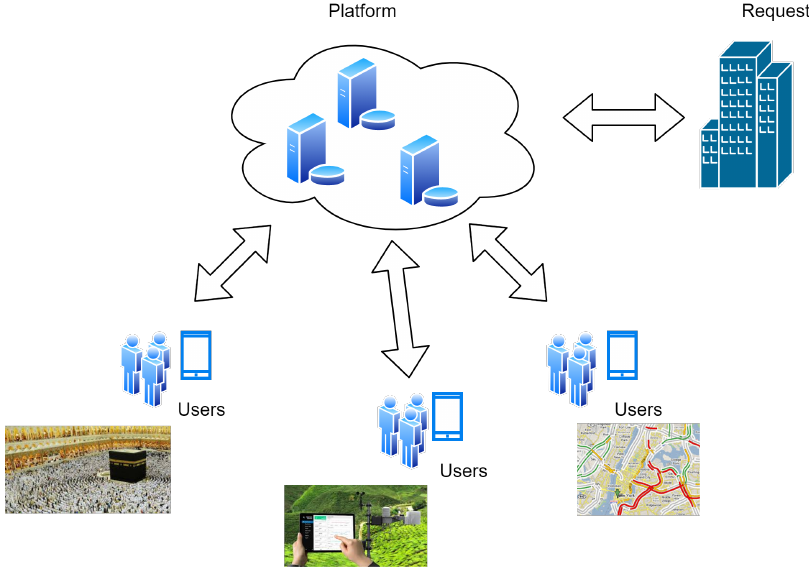
Figure 1. Applications of a Mobile Crowd-sourcing